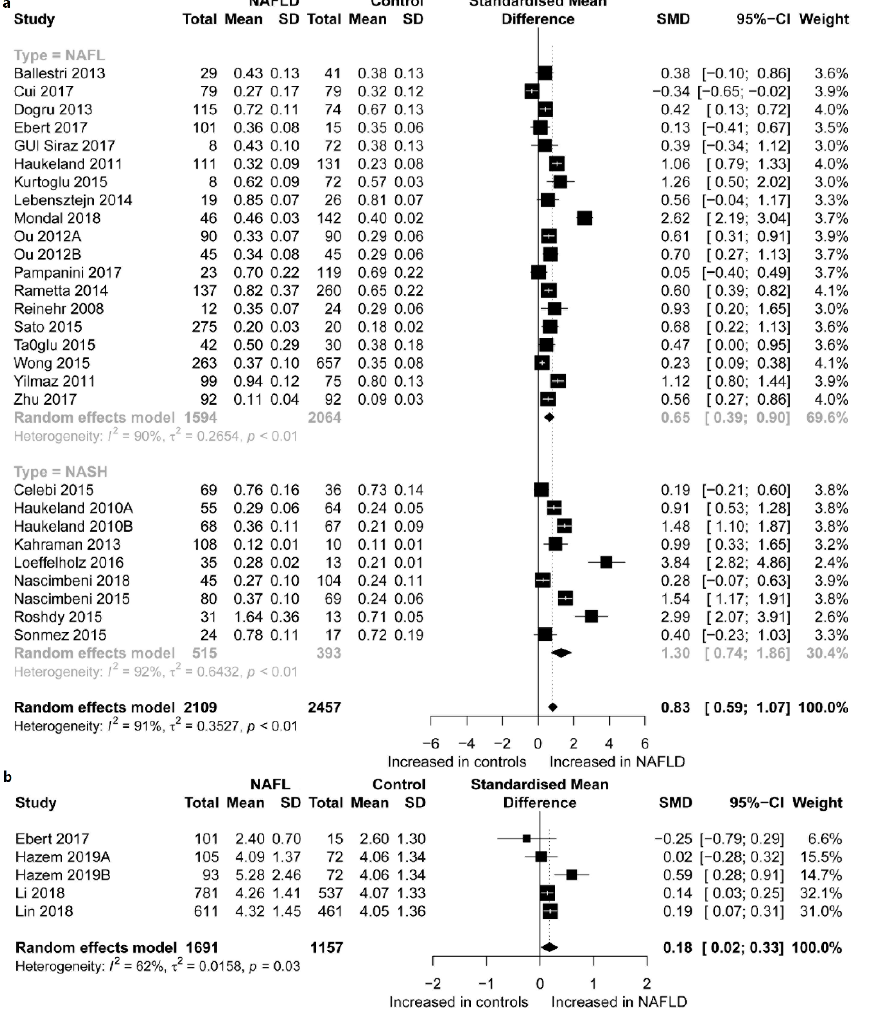
Figure 2. Forest plots of the standardized mean differences (SMDs) of fetuin-A concentrations ( a ), and fetuin-B concentrations ( b ) between the NAFLD participants and controls. The SMDs represent the effect sizes of fetuin-A, and fetuin-B concentrations on NAFLD. Each data marker represents a study, and the size of the data marker is proportional to the total number of individuals in that study. The summary effect sizes of fetuin-A, and fetuin-B concentrations are denoted by a diamond sign. The abbreviations in the forest plots are translated as follows: NAFLD, non-alcoholic fatty liver disease; NASH, non-alcoholic steatohepatitis; NAFL, non-alcoholic fatty liver; SMD, standardized mean difference.